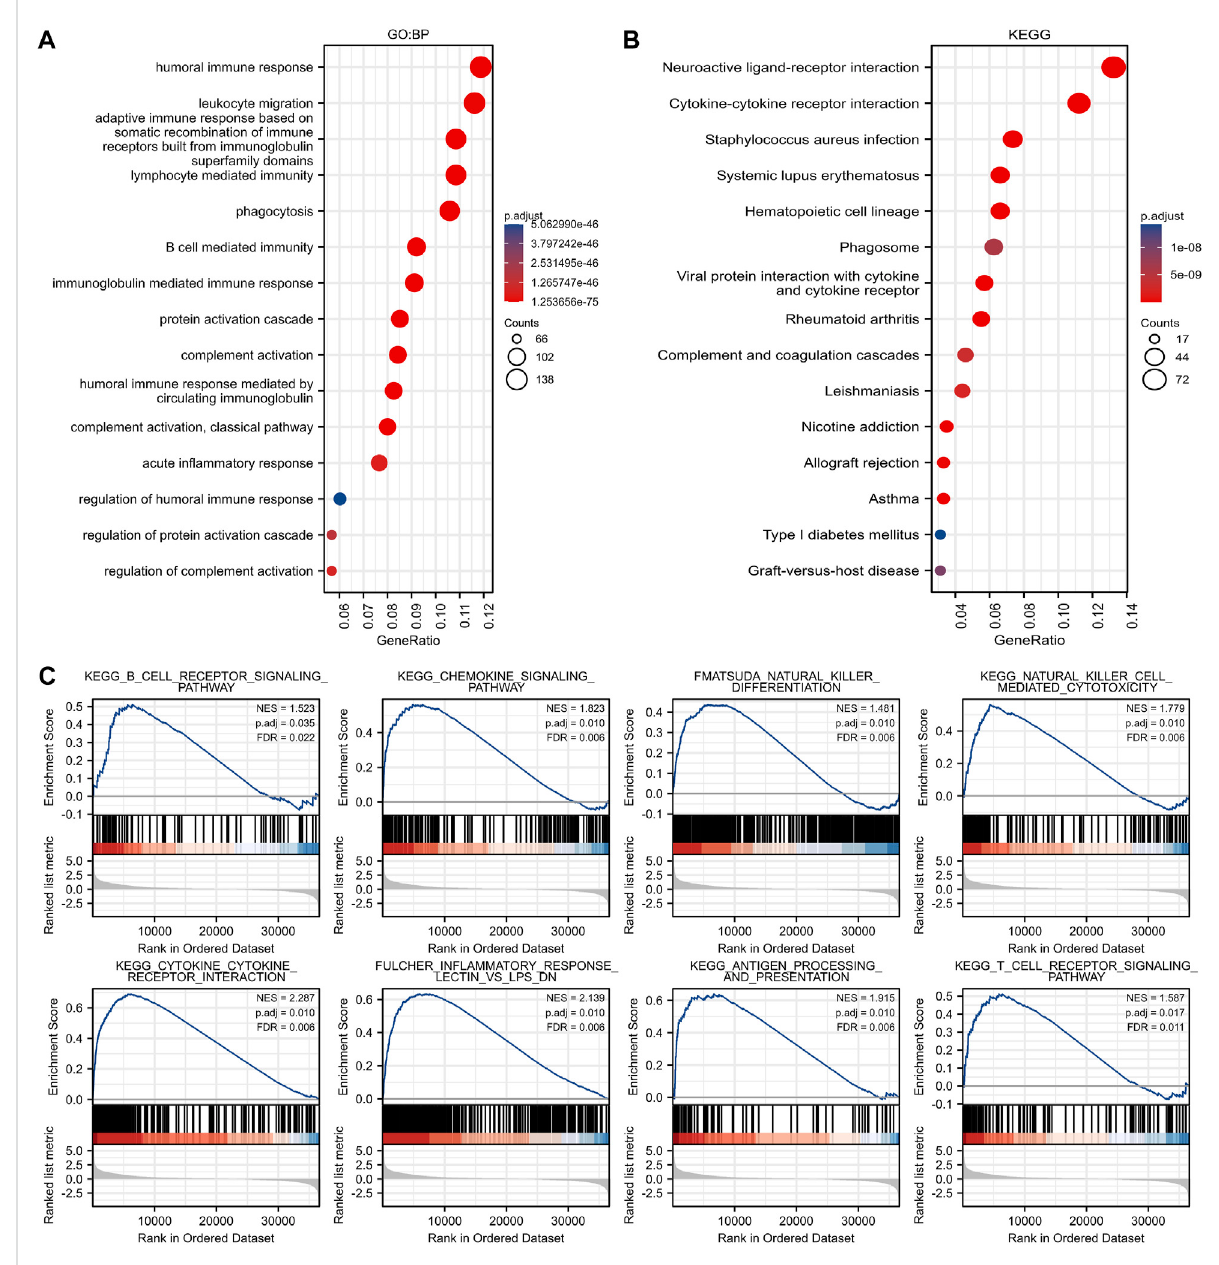
FIGURE 4 Immune-related pathways were enriched in GBP2-related genes. (A) The biological processes of GBP2-associated genes in the GO database are mainly associated with the human immune response. (B) The pathway enrichment of GBP2-associated genes in the KEGG database is mainly associated with immune processes such as neuroactive ligand-receptor interaction, cytokine-cytokine receptor interaction. (C) GSEA analysis of GBP2-associated genes revealed differential genes mainly associated with immune cell receptor signaling pathway, chemokine signaling pathway and other immune-related